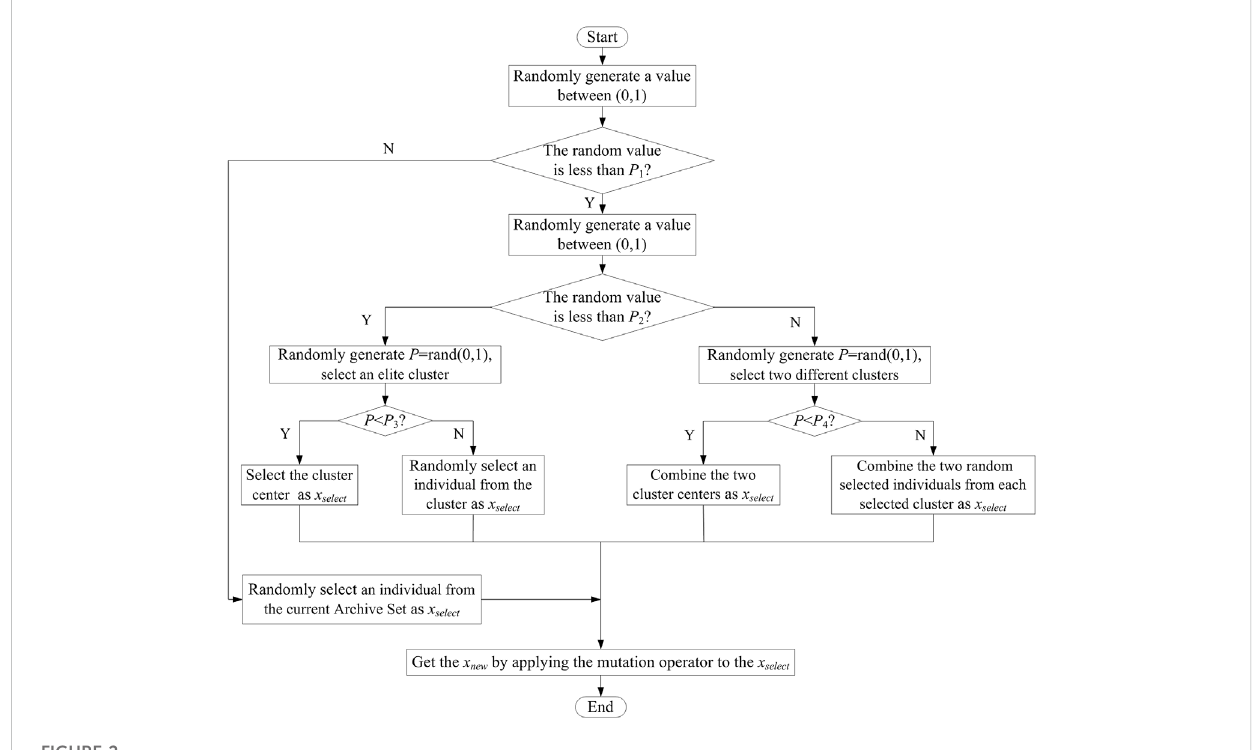
FIGURE 2 Update operation fl ow of BSO